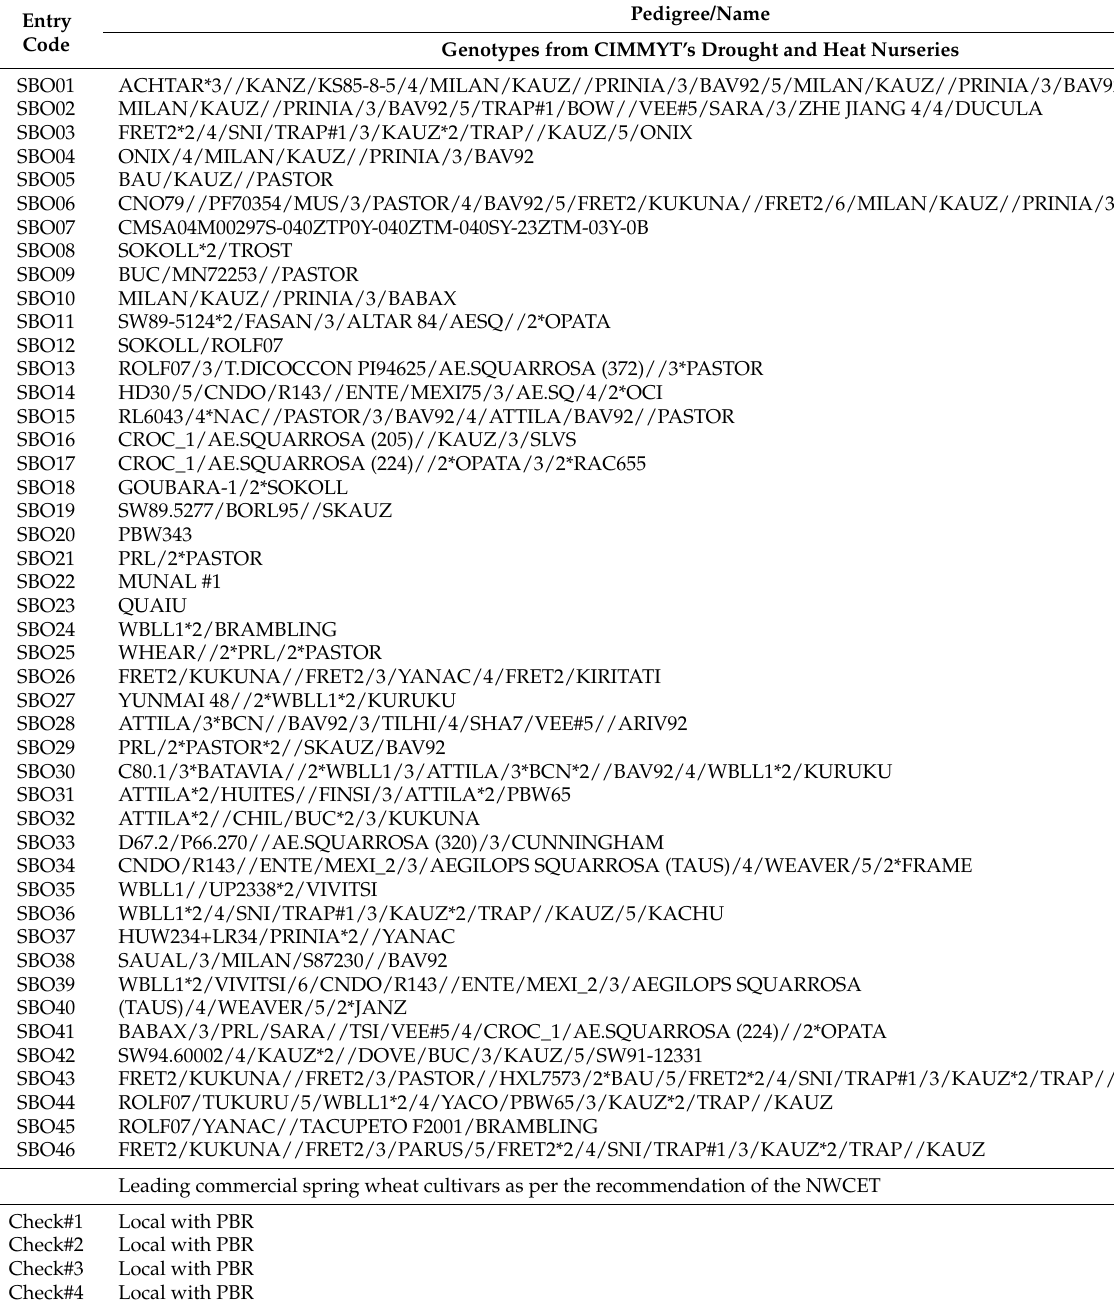
Table 1. List of wheat genotypes used in the